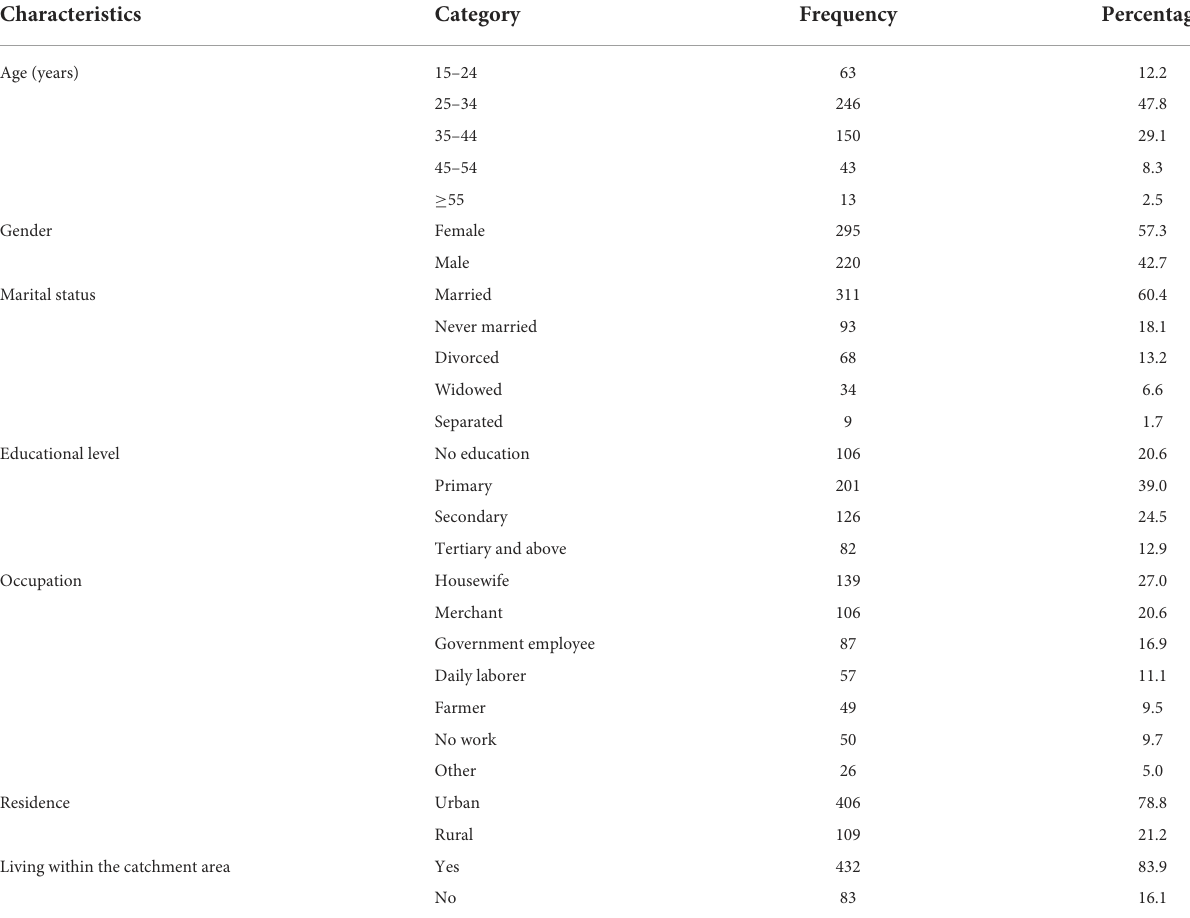
TABLE 1 Baseline socio-demographic characteristics of participants at the initiation of ART at WSUCSH, Southern Ethiopia, 2012–2021 ( n = 515).